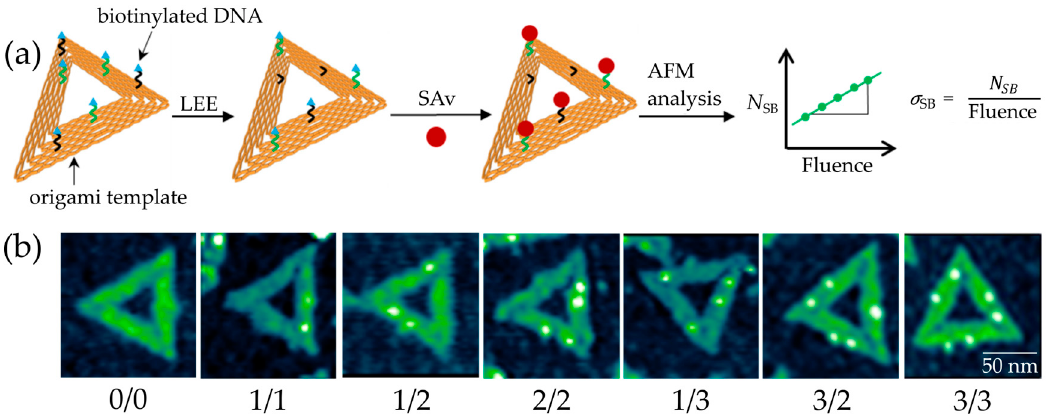
Figure 1. ( a ) Scheme of the DNA origami structure and the experimental procedure to determine the absolute cross section of DNA strand breakage. Each DNA origami can carry two different (black and green) biotinylated target sequences. Incubation with streptavidin (SAv) marks the intact DNA sequences. ( b ) AFM images of DNA origami nanostructures irradiated at 7 eV electron energy. Each bright spot indicates an intact DNA target sequence.